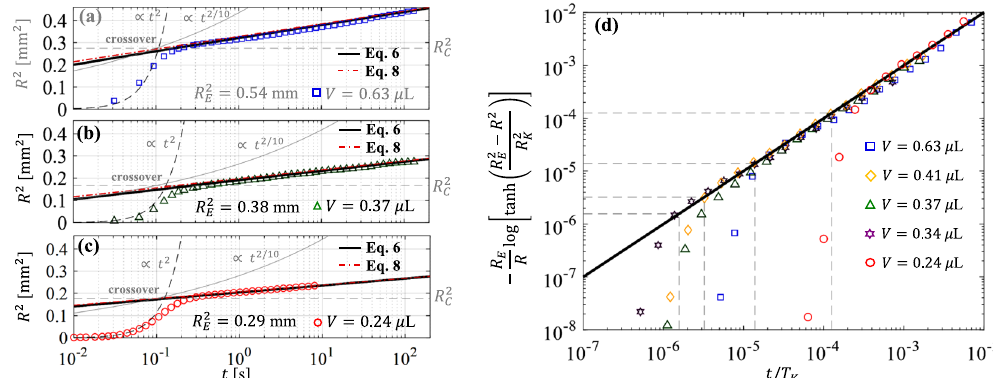
Figure 2. Experimental results and analytical predictions. ( a – c ) Square contact radius R 2 vs. time t for droplets of volume V = 0.24, 0.37, & 0.63 μ L. Markers correspond to experimental results. The crossover radius R C is predicted by Eq. (9) for α = 0.55. R E is the expected equilibrium contact radius for each case. Power-law fits R ∝ t and R ∝ t 0.1 are included for comparison. ( d ) Experimental data for droplets with different volumes (markers) scaled according to Eq. (6). Time is normalized by the kinetic time defined in Eq. (7). Dashed lines are predictions from Eq. (9) for the crossover to kinetic spreading. Analytical fits via Eqs (6–9) employ the parameters reported in Table 1.